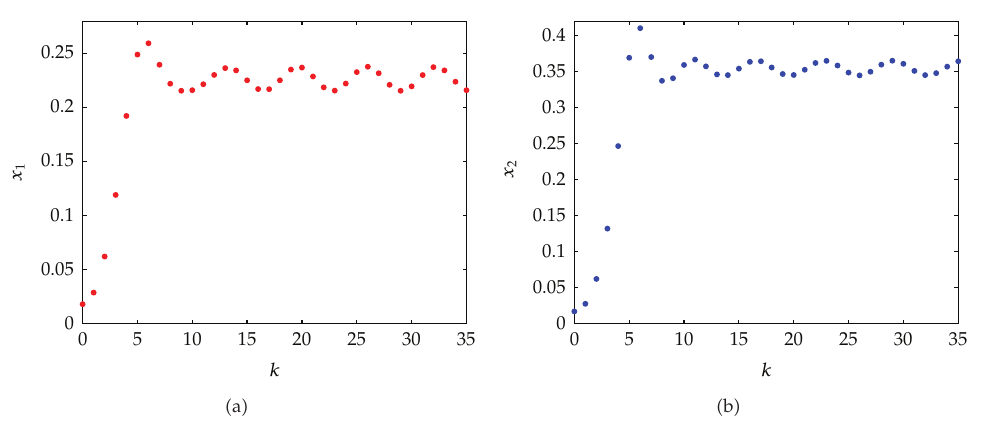
Figure 1: Permanence of system (cid:4) 4.1 (cid:7) with x 1 (cid:4) − 1 (cid:7) (cid:9) 0 . 2, x 1 (cid:4) 0 (cid:7) (cid:9) 0 . 018, x 2 (cid:4) − 1 (cid:7) (cid:9) 0 . 3, and x 2 (cid:4) 0 (cid:7) (cid:9) 0 . 017. (cid:4) a (cid:7) Time series of x 1 . (cid:4) b (cid:7) Time series of x 2